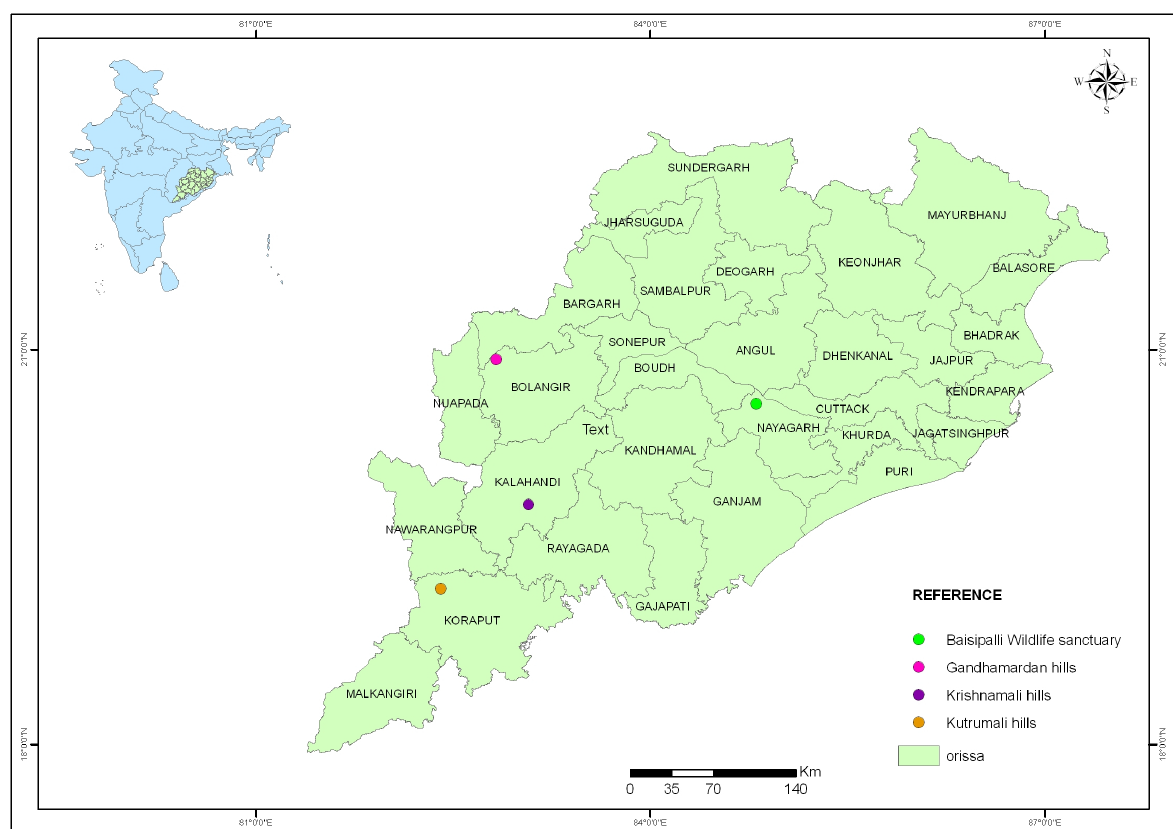
Figure 1. New locality records of Phallus indusiatus in